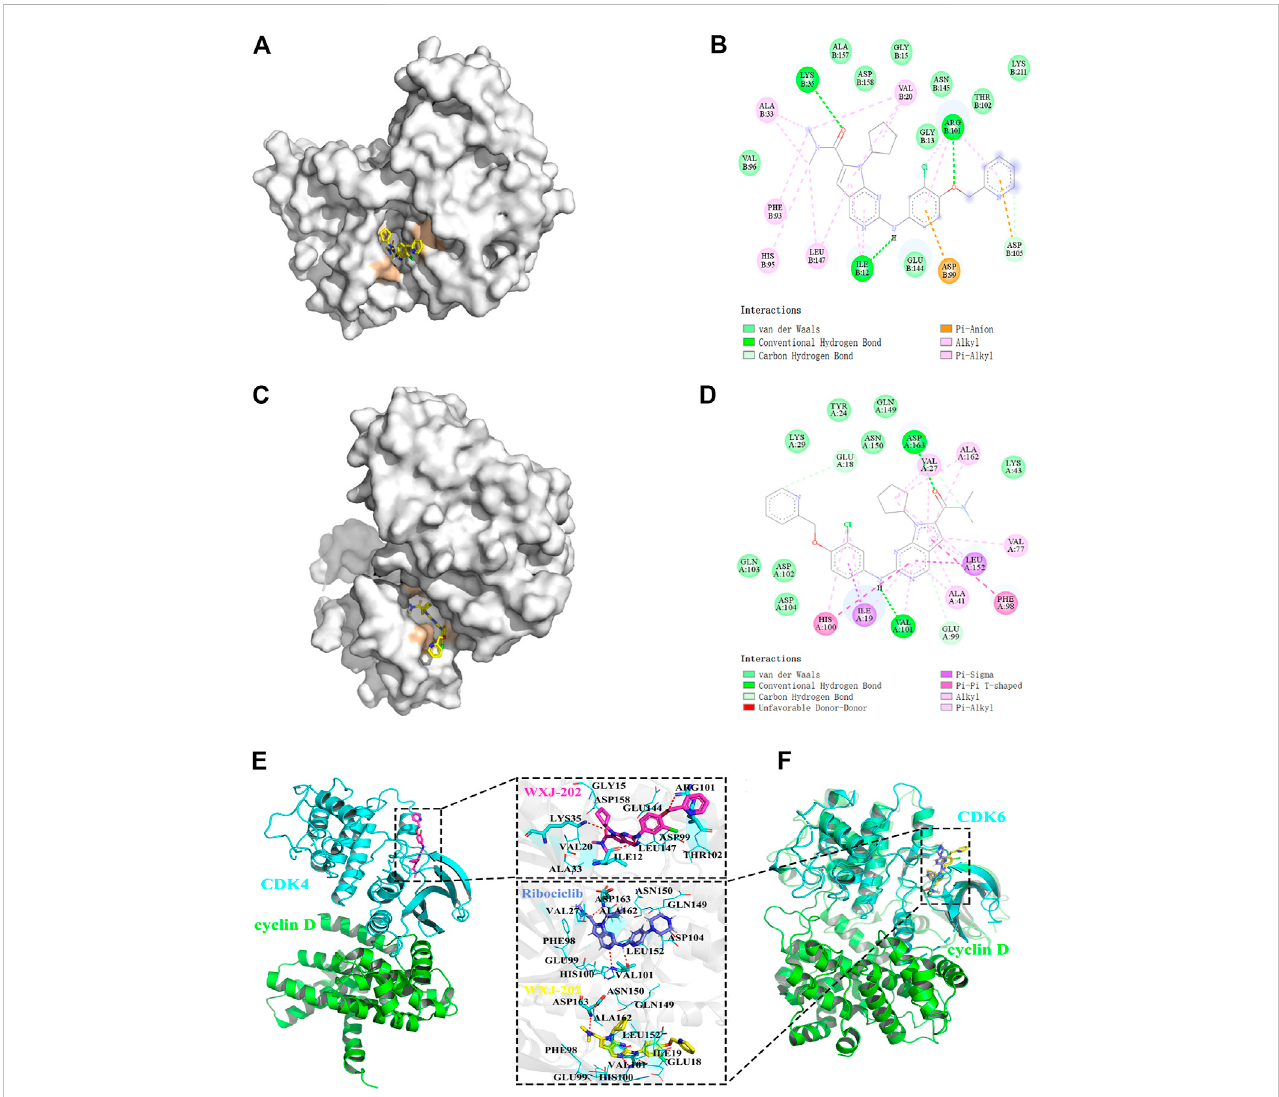
FIGURE 2 Molecular docking between compound WXJ-202 with CDK4 and CDK6. (A) Site of docking binding of compound WXJ-202 in CDK4 protein kinase. (B) 2Dinteractionmap ofcompound 202with CDK4 proteinkinase. (C) Positionofthecompound202 bindingin CDK6 proteinkinase. (D) 2Dinteraction mapof compound 202 with CDK6 protein kinase. (E) Interactions between the CDK4 active binding site and compound WXJ-202. (F) Interactions between the CDK6 active binding site and compound WXJ-202. Complex model of CDK4 (blue) and Cyclin D (green) was taken from the PDB database (ID: 2W9Z). The complexmodelofCDK6-Cyclin D(green)wastaken fromthePDBdatabase(ID: 1XO2). Asareference,thecrystal structure ofCDK6-Ribociclib(blue, ID: 5L2T) was also aligned to the protein-protein complex. Among, the residues forming hydrogen bonds with the inhibitor were shown as blue sticks, and the remaining residues were shown as blue lines, the red dashed lines indicate hydrogen